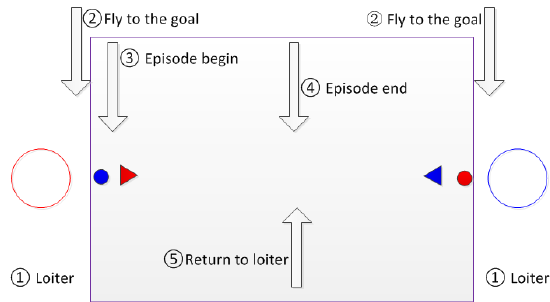
Figure 6. The simulation